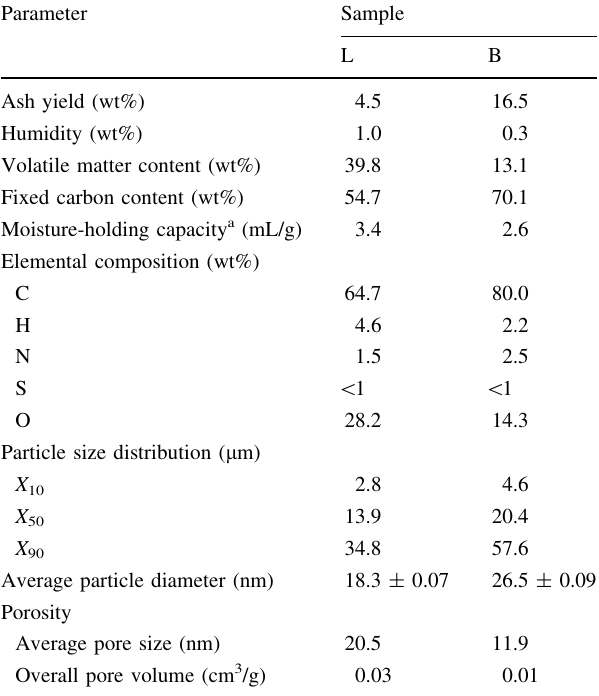
Table 3 Characteristics of the pristine coal samples after drying at 105 (cid:3) C for 20 h Parameter